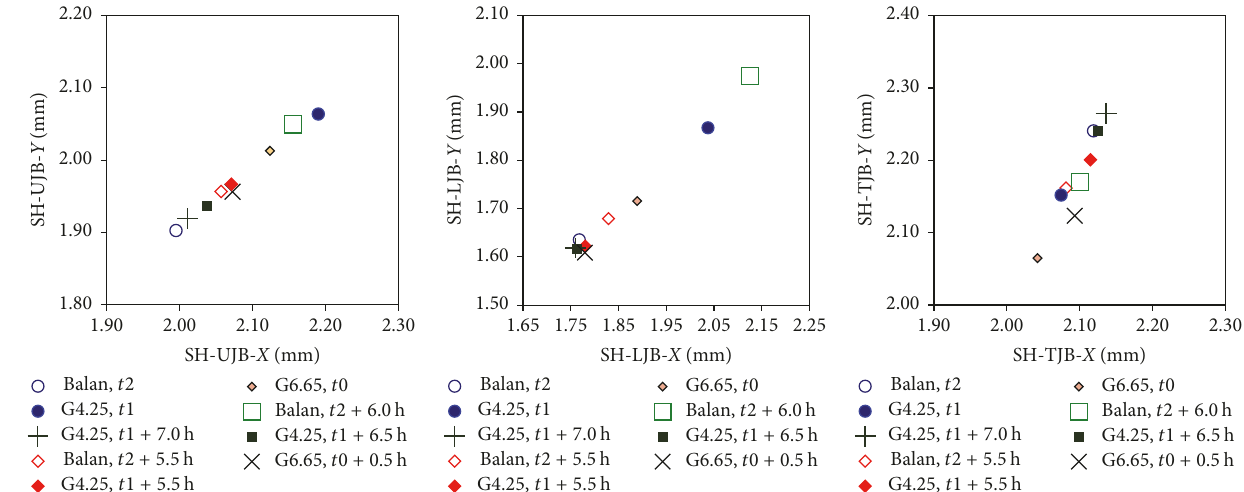
Figure 9: Shaft eccentricity in the upper, lower, and turbine journal bearings of a LHG at speed-no-load condition, with the generator rotor balanced (Balan) and unbalanced, with ISO quality grades G4.25 and